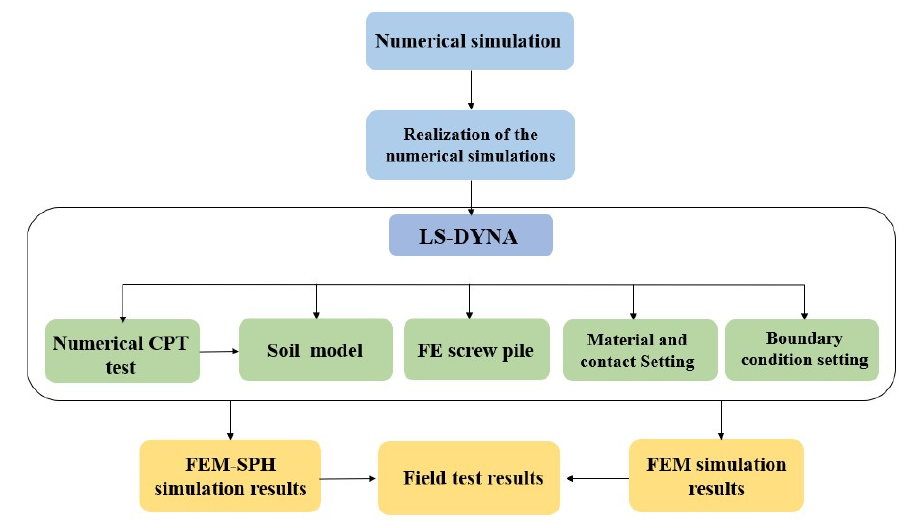
Figure 3. The idea of numerical simulations.